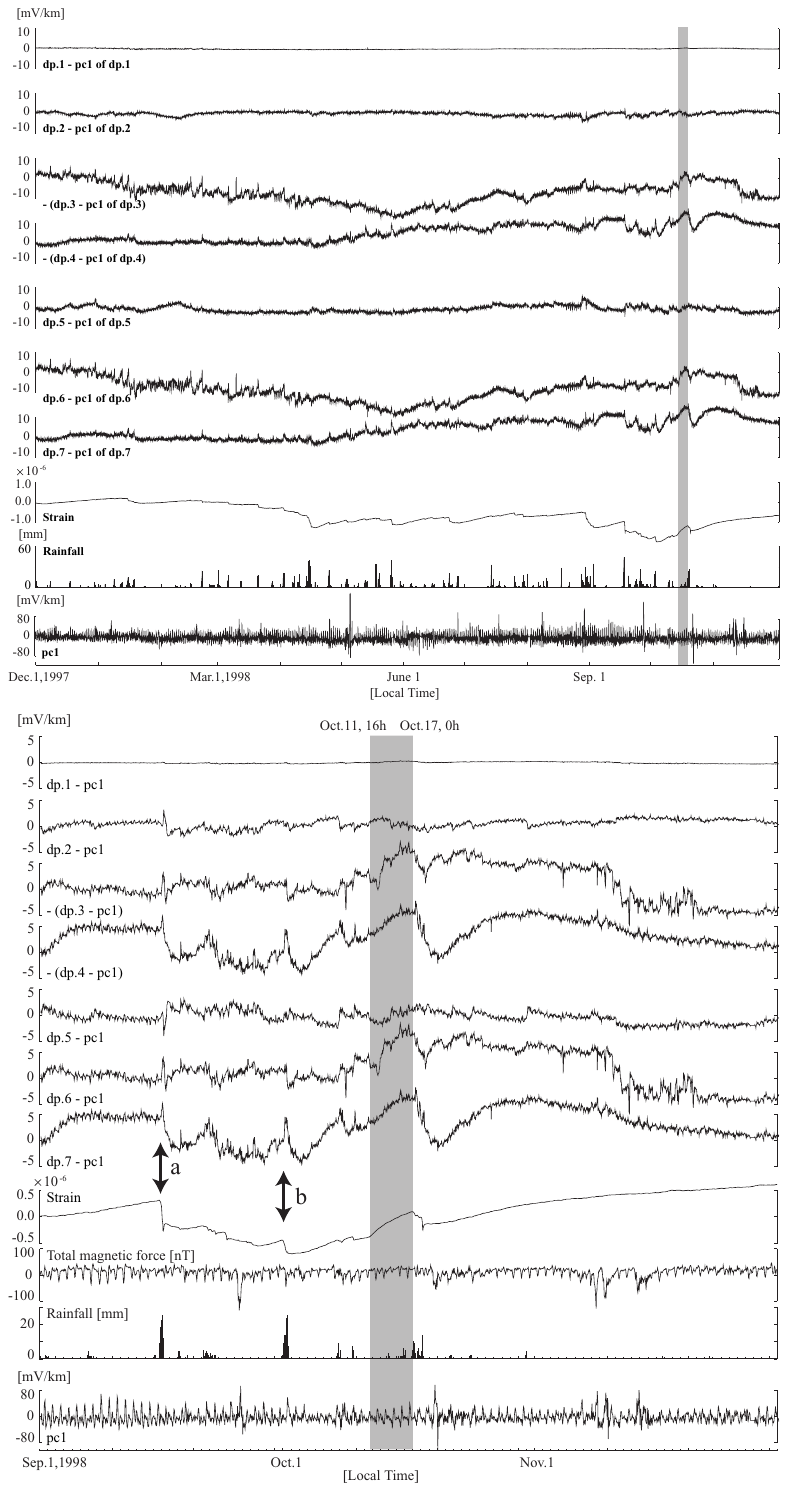
Fig. 4. (a) Upper seven panels are one-year records and (b) magnified three-month records of the geoelectric field after eliminating the first principal component pc1 shown in the bottom panel. The anomalous changes are made visible particularly in (b) . Other panels are the same as in Fig. 3a and b. Arrows a and b in (b) indicate heavy rainfall time. A shaded rectangle shows the period of the anomalous strain